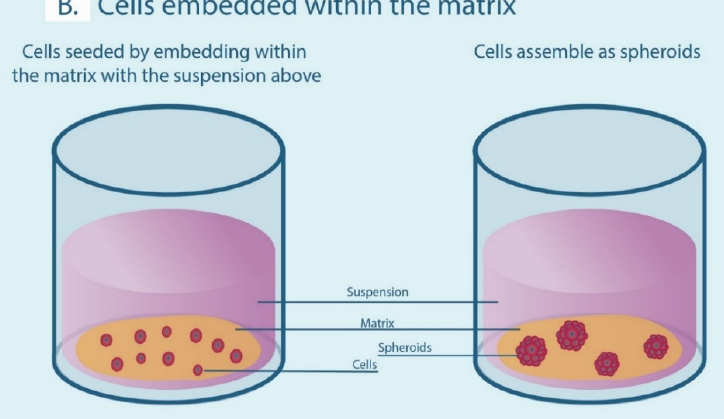
Figrue 2 Figure 2. Matrix-associated methods for generating spheroids. ( A ) Cells are seeded above the matrix-coated plates in a suspension. ( B ) Cells are embedded within the matrix to form